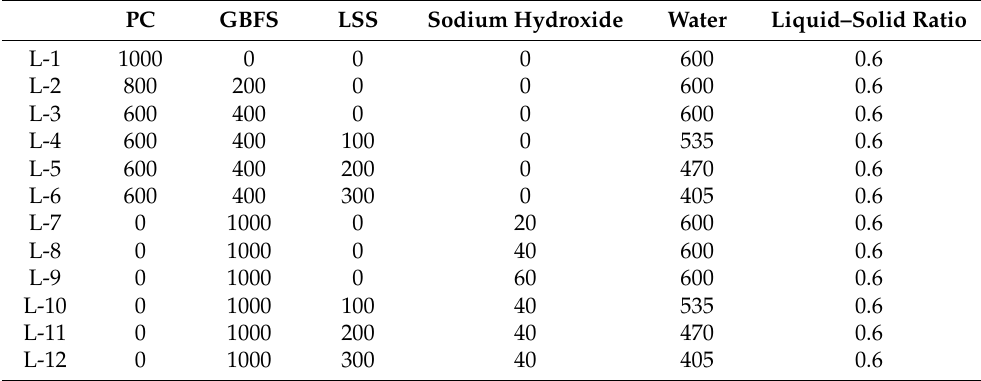
Table 2. Mix proportion of